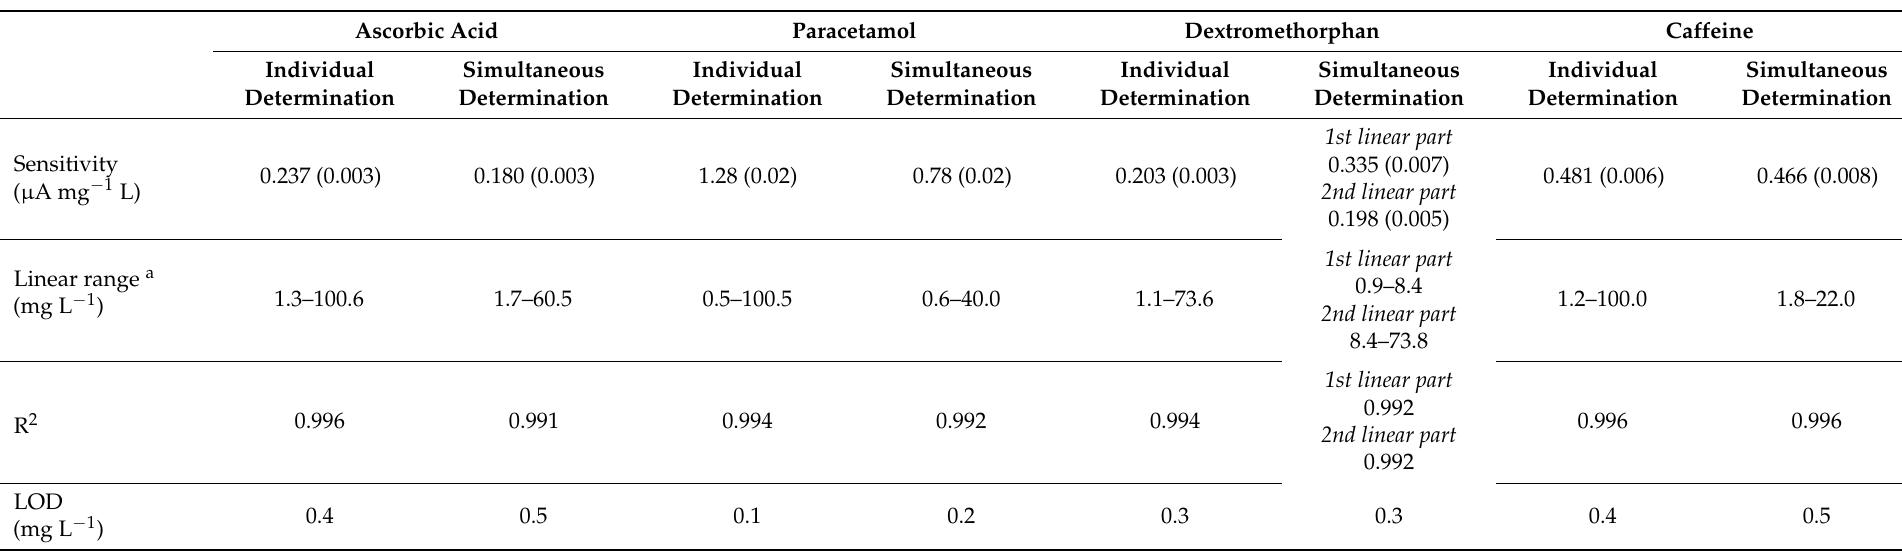
Table 1. Calibration data for the individual and simultaneous determination of target analytes on SPCE at acetate buffer at pH 5.0. The standard deviations are denoted by